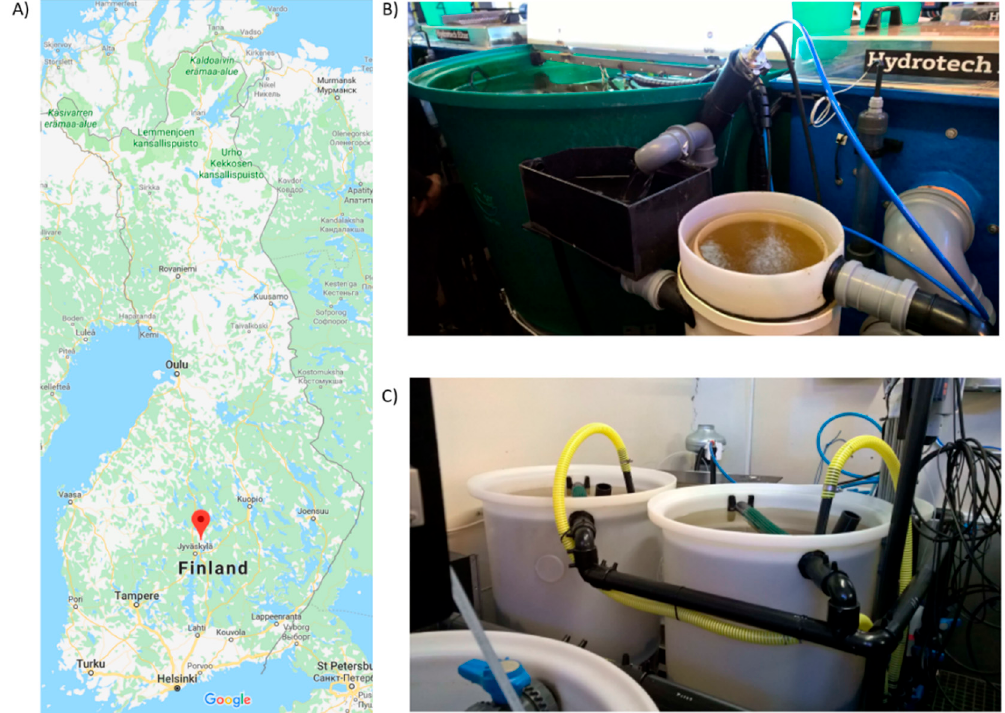
Figure 3. RAS farm location and an example of the fish tanks used. ( A ) Fish farm location in Laukaa, Finland. ( B ) Fish tank (in green) and solids removal units. ( C ) Fixed and moving bed biofilters.